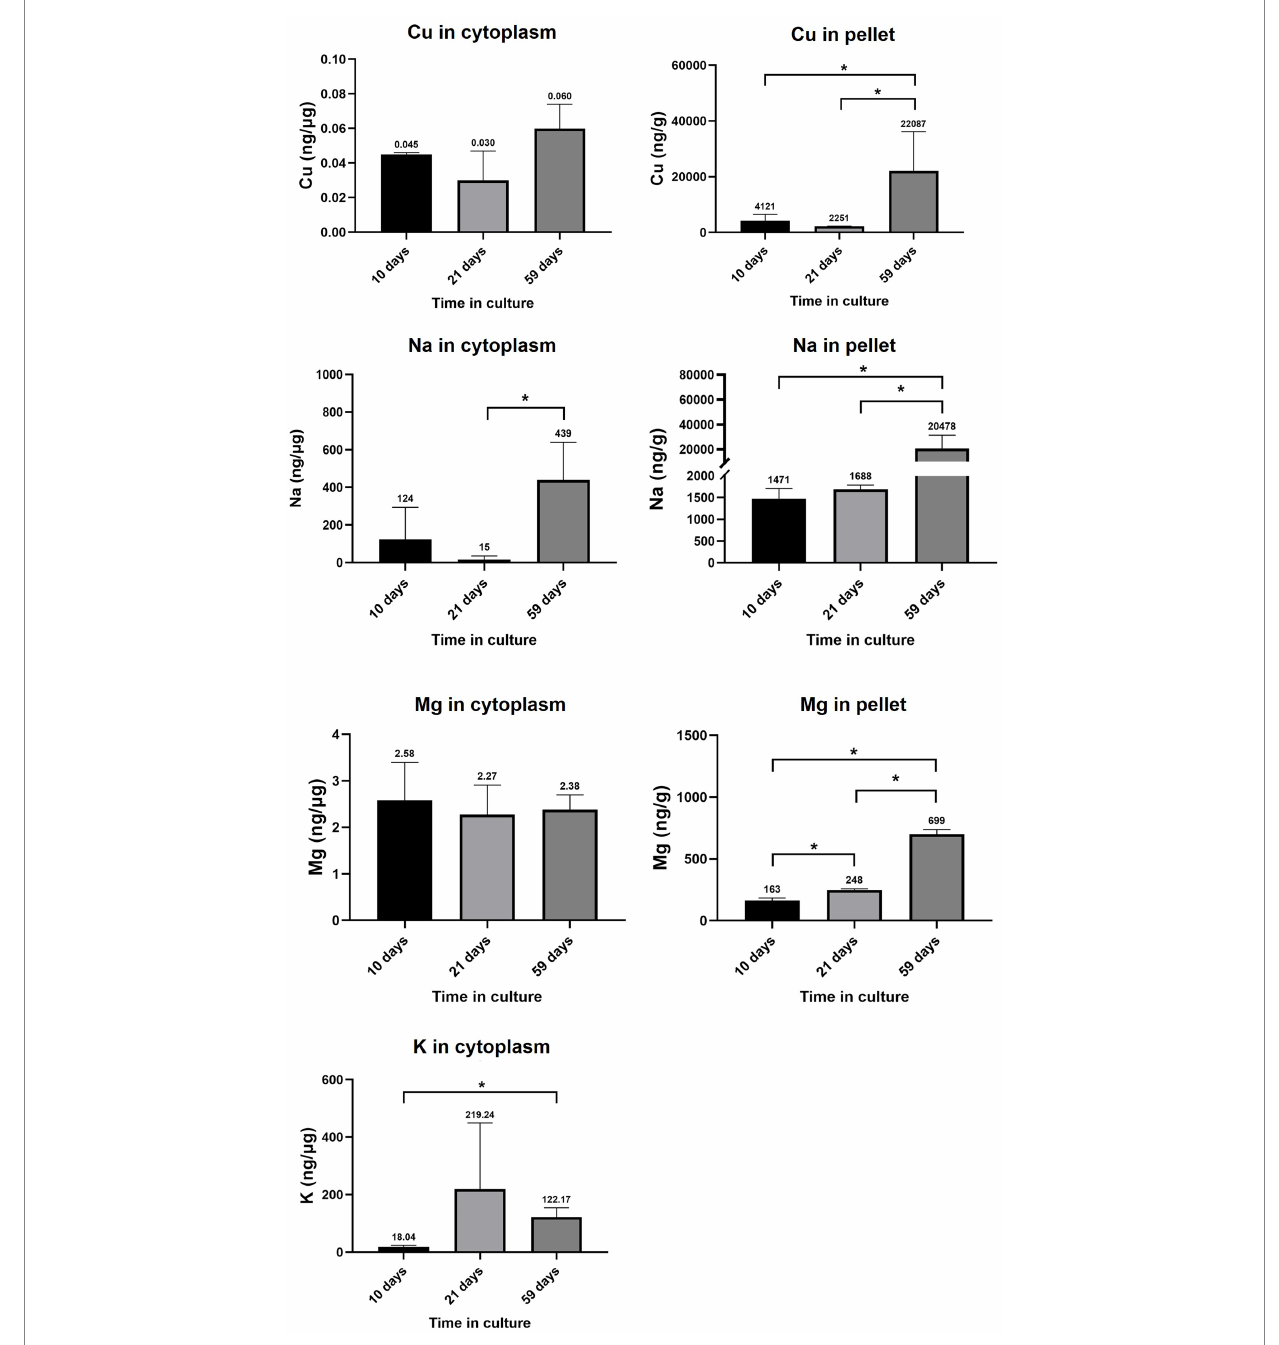
FIGURE 7 RPE levels of Cu, Na, Mg, and K in cytoplasmic and pellet fractions. Data is represented as concentration (ng· μ g − 1 total protein in the cytoplasm; and ng·g − 1 sample in the pellet) and error bars depict the standard deviation. *: significant p- value of two-way ANOVA (<